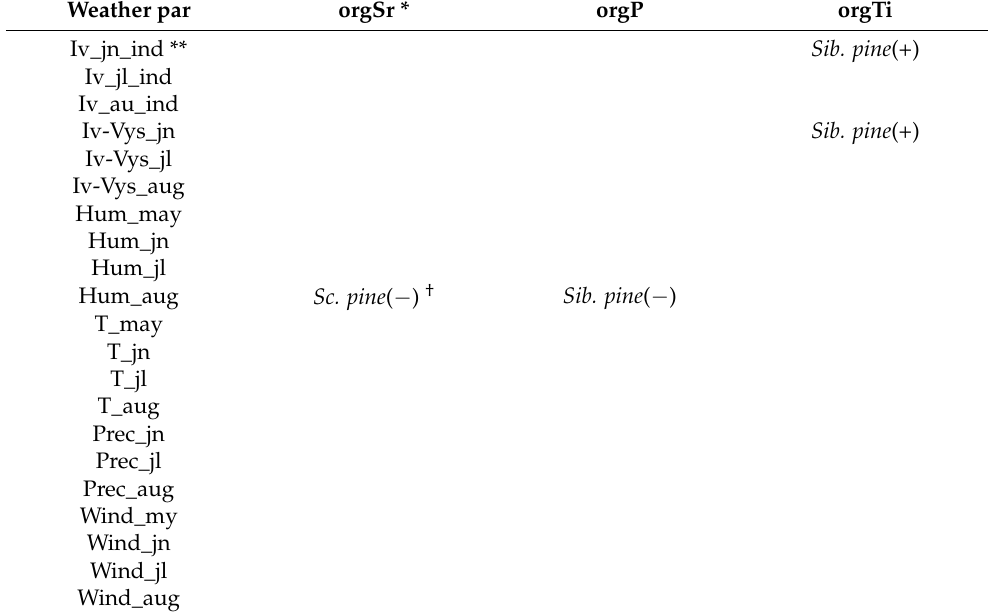
Table 2. Consistent correlations for the conifer species according to Kendall tau correlation